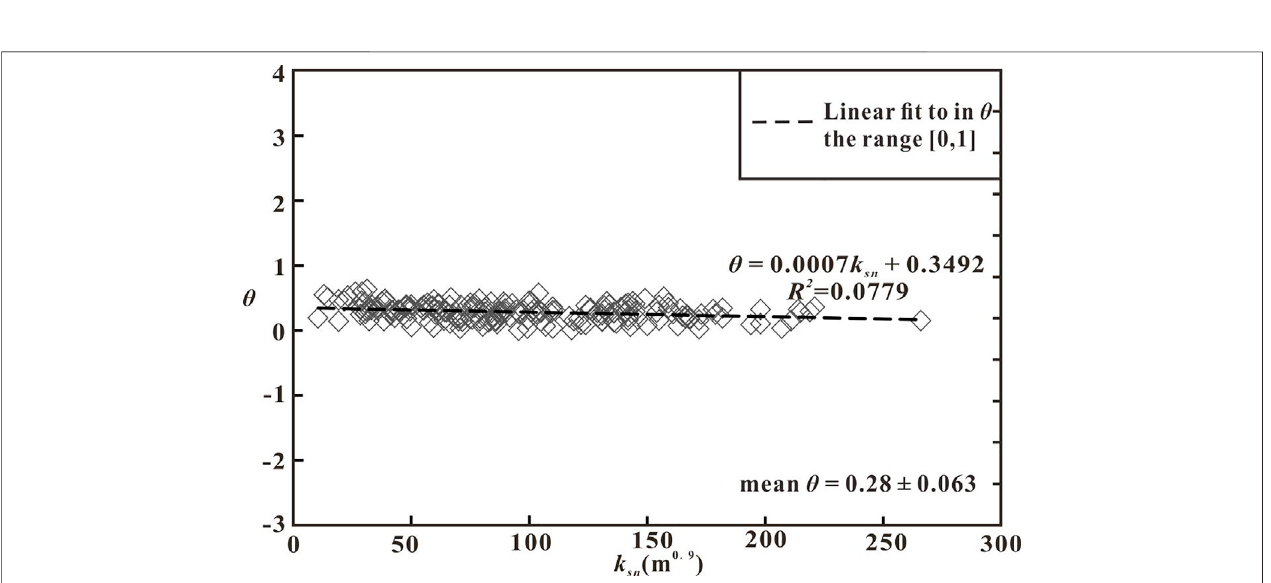
FIGURE 2 | Normalized channel steepness calculated for a reference concavity ( θ ref = 0.45) plotted against the actual concavity ( θ ) of the pro fi le. The streams extracted for river pro fi le analysis and the steepness and concavity indices of each segment are in the Supplementary File .